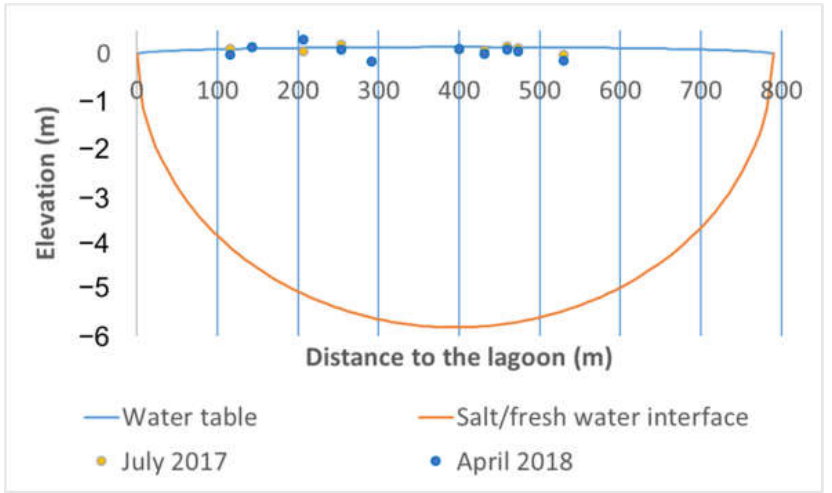
Figure 6. Calculation of the piezometric surface area of the aquifer using Henry’s solution and the freshwater/salt water interface using the Ghyben–Hezberg solution on the Wine sector.